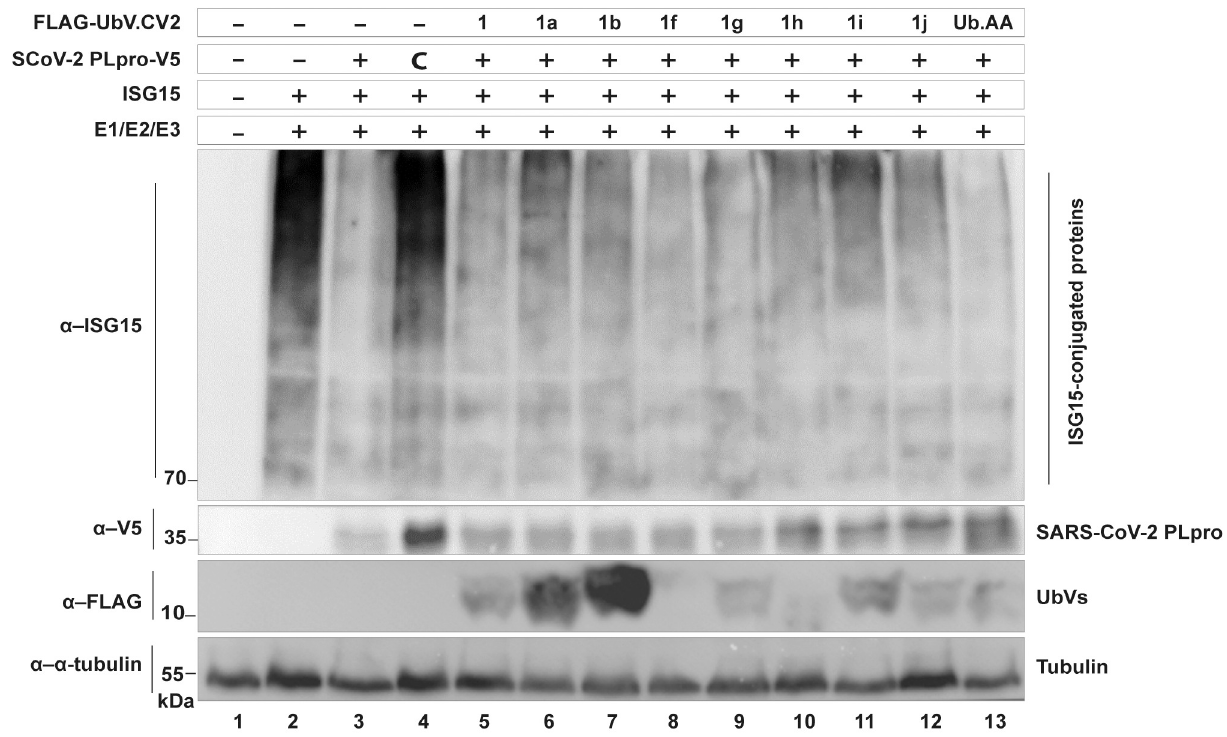
Fig 2. UbVs inhibit the deISGylation activity of SARS-CoV-2 PLpro. Inhibition of the deISGylation activity of SARS-CoV-2 PLpro by some UbVs, visualised by co-transfection of HEK293T cells with plasmids encoding for the E1, E2, and E3 enzymes necessary for conjugation of ISG15, together with hISG15, as well as SARS-CoV-2 PLpro-V5 (wildtype or catalytic mutant ‘C’) and FLAG-UbVs. Lysates were collected 48 hours post transfection and were subjected to western blot analysis. Whereas PLpro normally removes ISG15 from cellular substrates, co-transfection of some the UbVs inhibits the deISGylation activity of